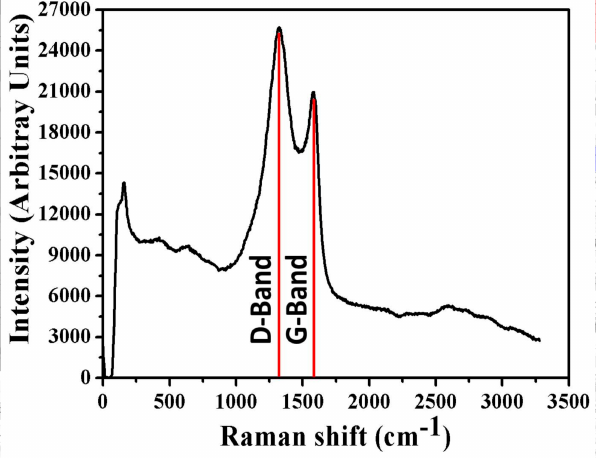
Figure 4. Raman spectrum of the prepared